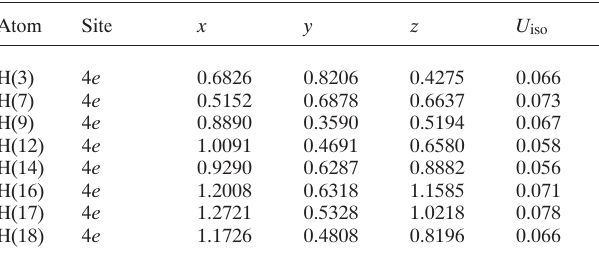
Table 2. Atomic coordinates and displacement parameters (in Å 2 )